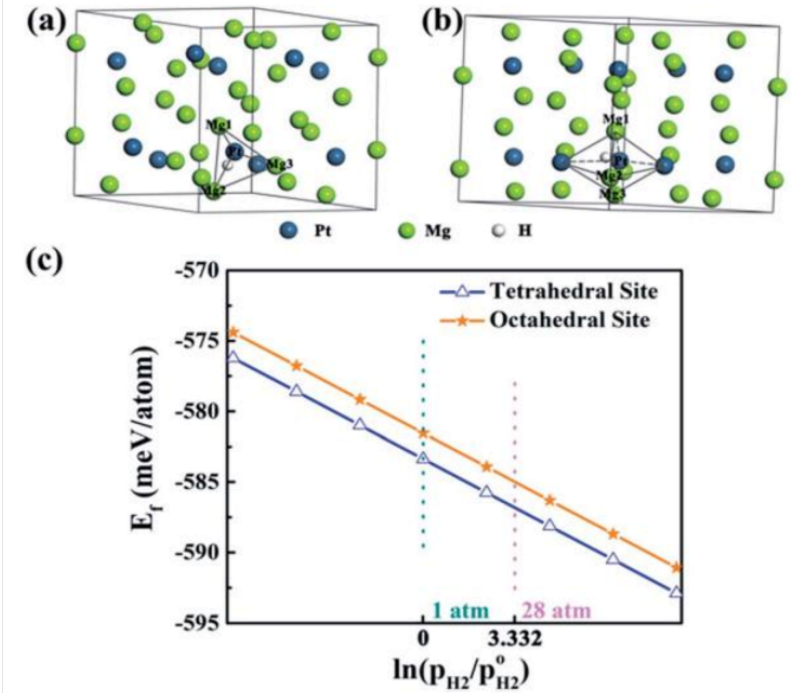
Figure 30. DFT calculation results for the Mg@Pt composite. ( a ) Interstitial hydrogen atom in the tetrahedral sites of Mg 3 Pt. ( b ) Interstitial hydrogen atom in the octahedral sites of Mg 3 Pt. ( c ) Defect formation energy of H-atom dependence on hydrogen pressure at the tetrahedral and octahedral sites. ( a – c ) Reproduced with permission [207]. Copyright 2019, Royal Society of